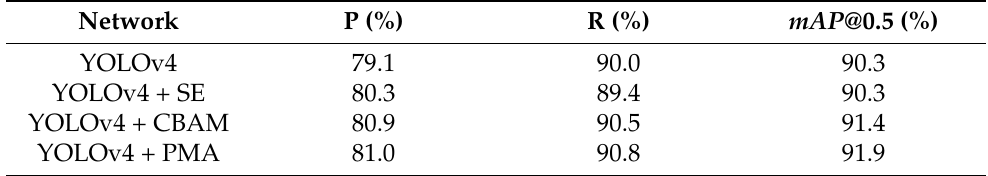
Table 5. Detection results from adding different attention modules to